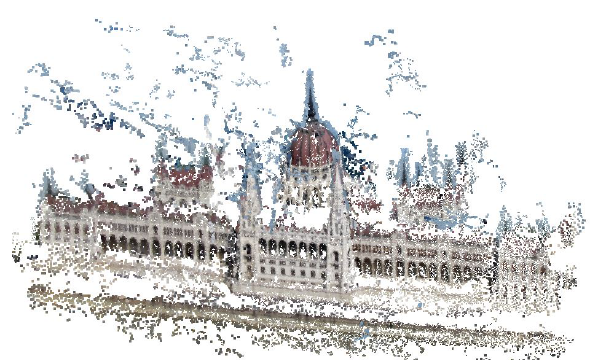
Figure 9. Dense point cloud of the Parliament building just after the reconstruction